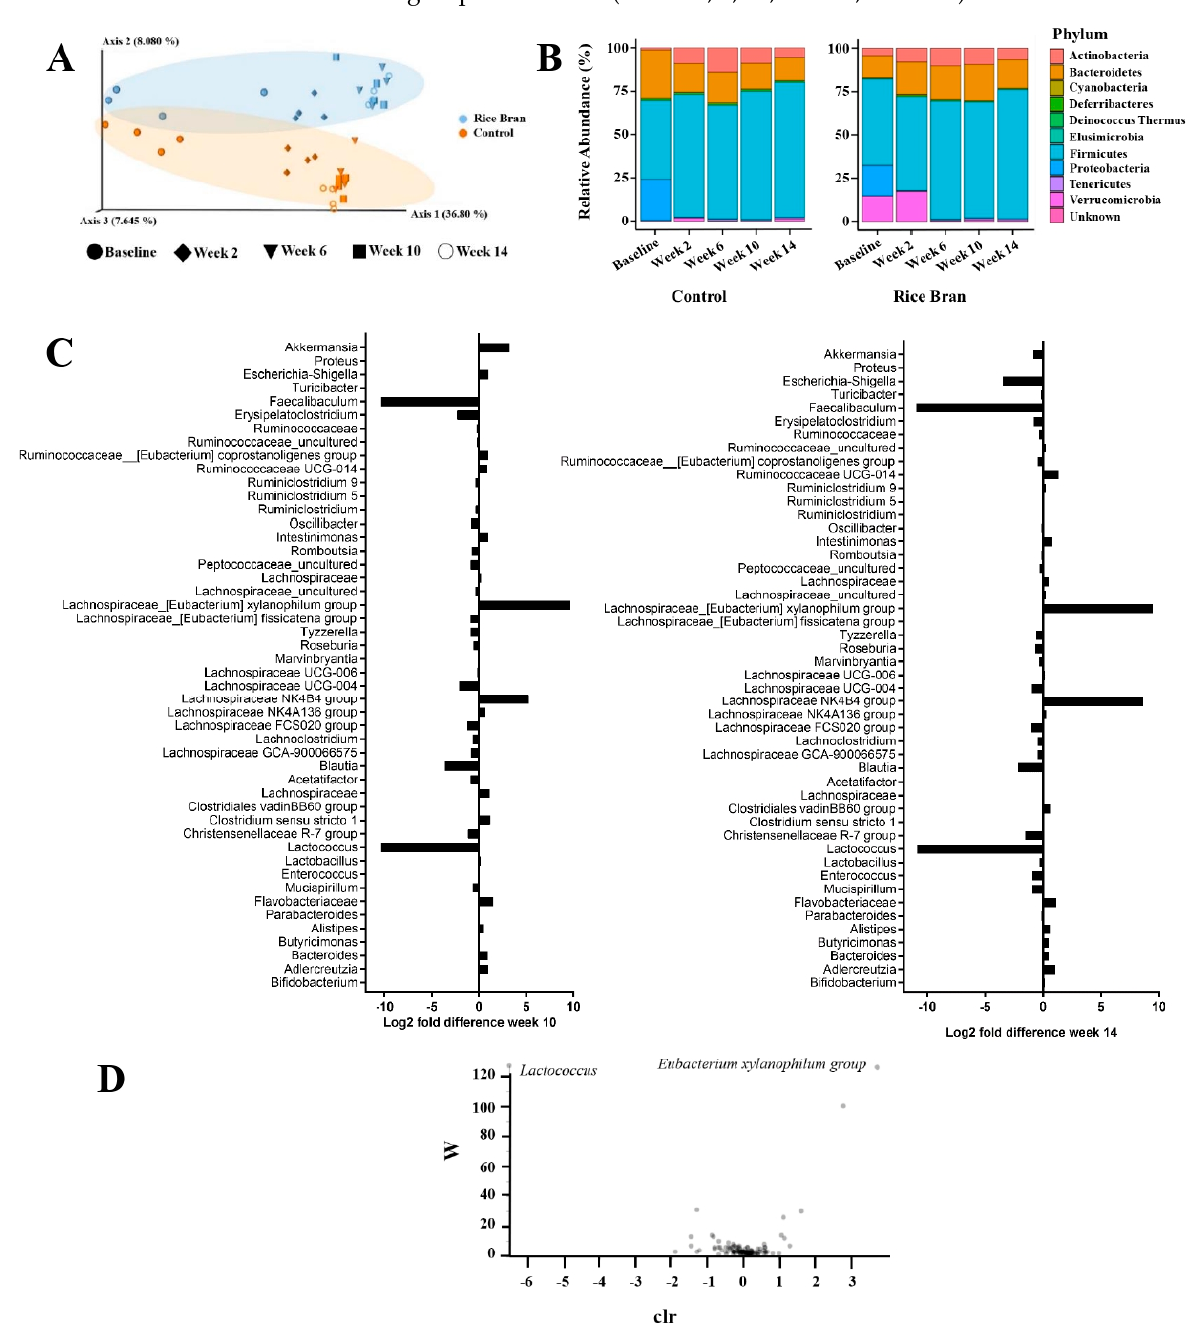
Figure 2. Time-dependent fecal microbiota changes following control and rice bran intake in AOM/DSS-treated mice. ( A ) Unweighted UniFrac PCoA plot of the fecal microbiome separation by diet: rice bran in blue, control in orange. ( B ) Phylum-level changes in rice bran and control groups at baseline, and 2, 6, 10, and 14 weeks. ( C ) Genus-level log2 fold differences in the rice bran group compared to the control at week 10 and week 14. ( D ) ANCOM volcano plots, centered log ratio (clr) with W test statistic, and differentially abundant features between diet types. Statistically significant features as calculated by ANCOM are labelled.